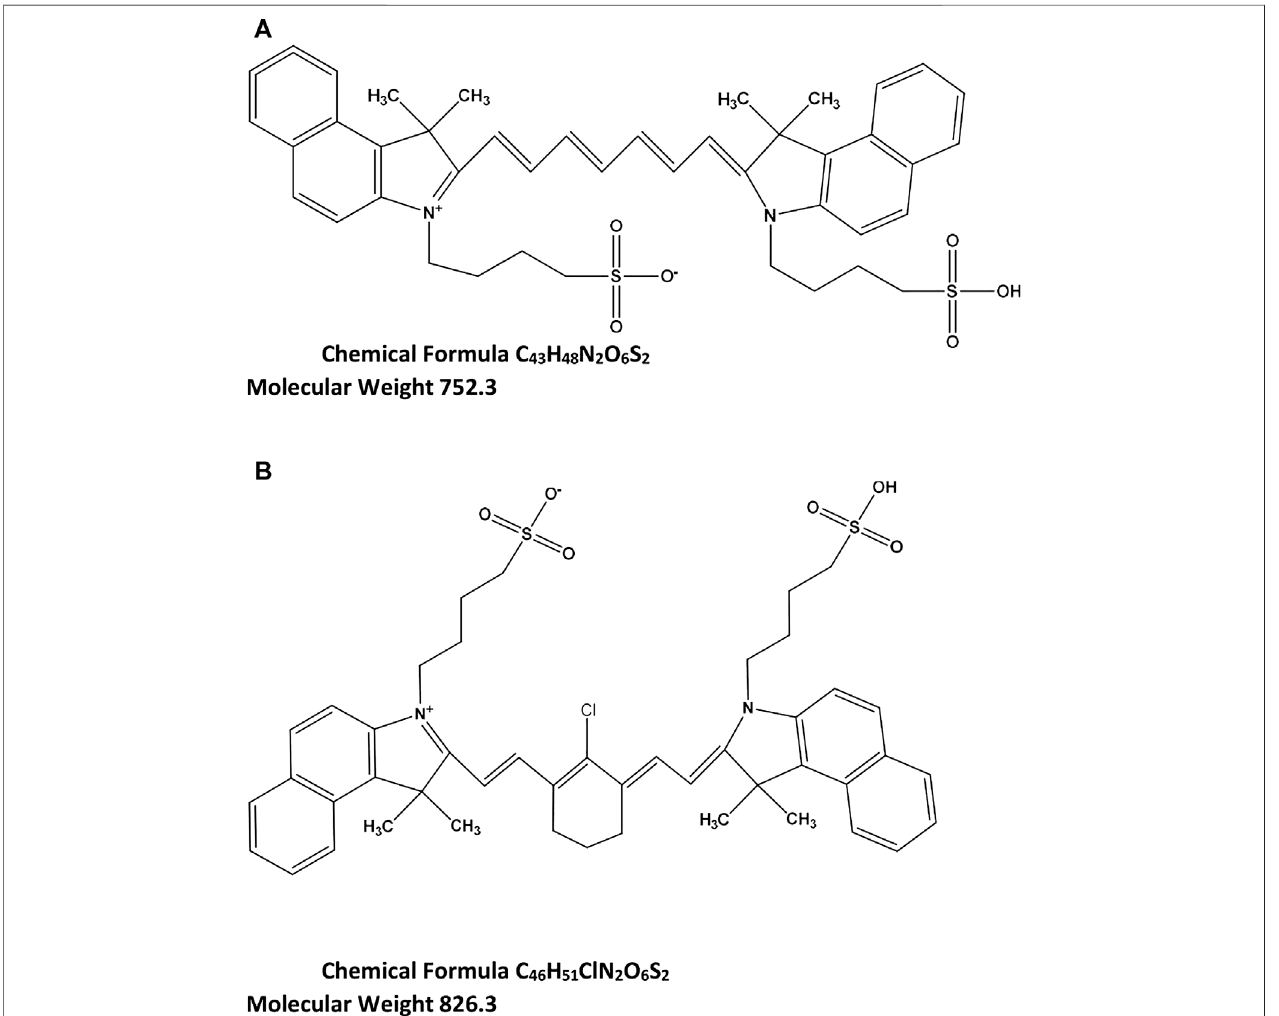
FIGURE 1 | Chemical structure and formula of ICG (A) and IR-820 (IS) (B) .